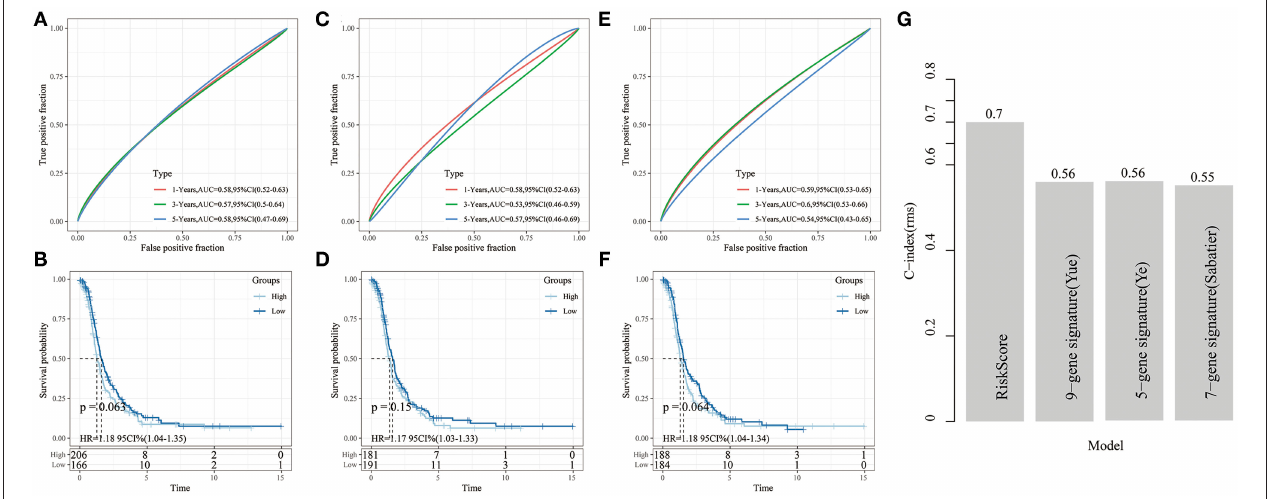
FIGURE 13 | (A,B) ROC analysis of 9-gene signature (Yue) and KM curve of High/Low samples; (C,D) ROC analysis of 7-gene signature (Sabatier) and KM curve of High/Low samples; (E,F) ROC analysis of 5-gene signature (Ye) and KM curve of High/Low grouping sample. (G) The C-index comparison curve among four prognostic